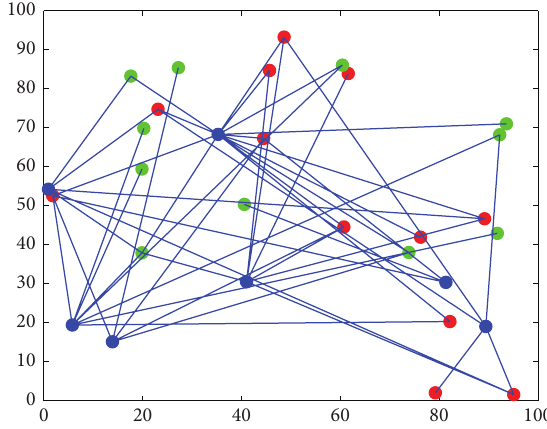
Figure 3: The initial supply network of FAW Xiali.